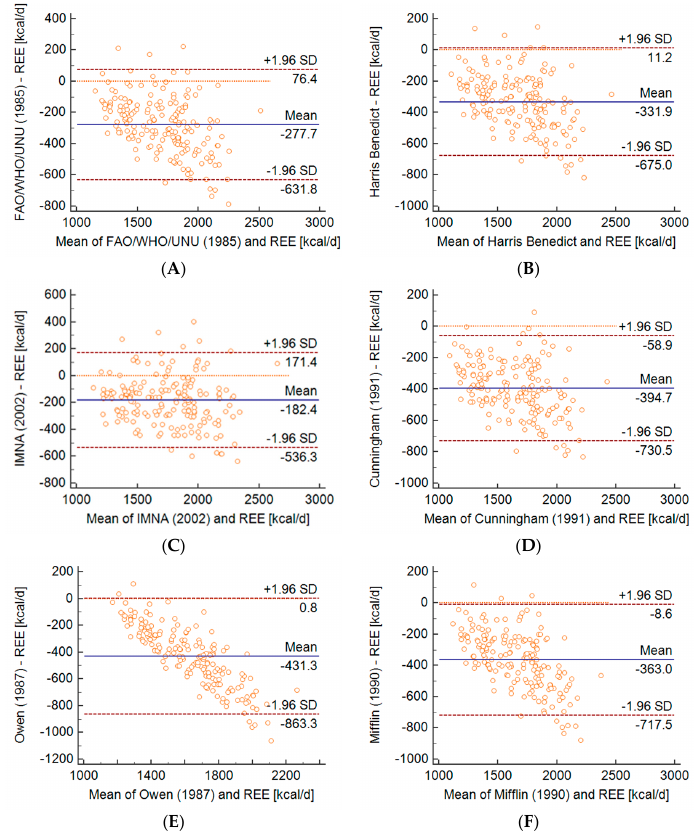
Figure 1. Bland-Altman plots presenting the agreement between measured and predicted resting energy expenditure (REE) by the equations of ( A ) FAO / WHO / UNU, ( B ) Harris Benedict, ( C ) IMNA (Institute of Medicine of the National Academies), ( D ) Cunningham, ( E ) Owen, ( F ) Mifflin. All of the formulas above were used in the selection of children who regularly exercise. The mean value of the differences between measured and predicted REE (bias) is indicated by the solid line. The dashed lines delimit the 95% confidence interval. All regression lines were statistically significant at p < 0.0001, indicating a systematic bias.